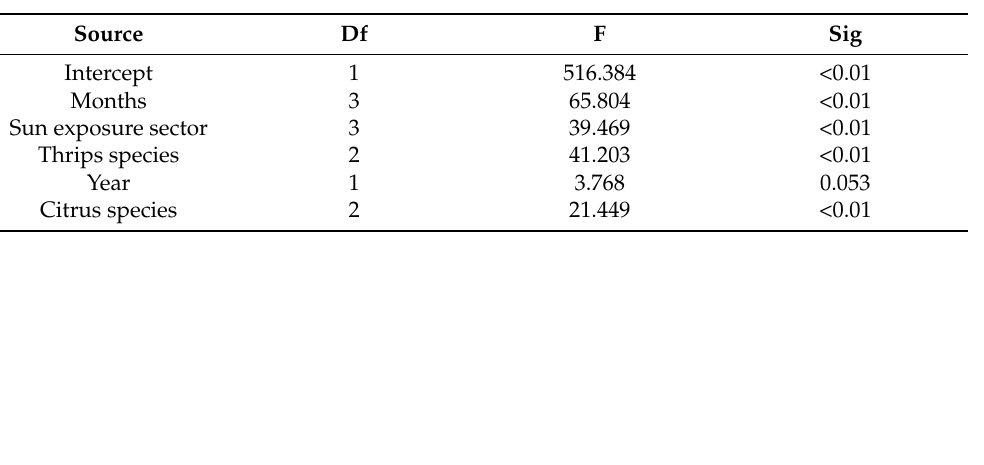
Table 3. Univariate analysis (UNIANOVA) evaluating the abundance of thrips species in relation to the variables of monitoring citrus